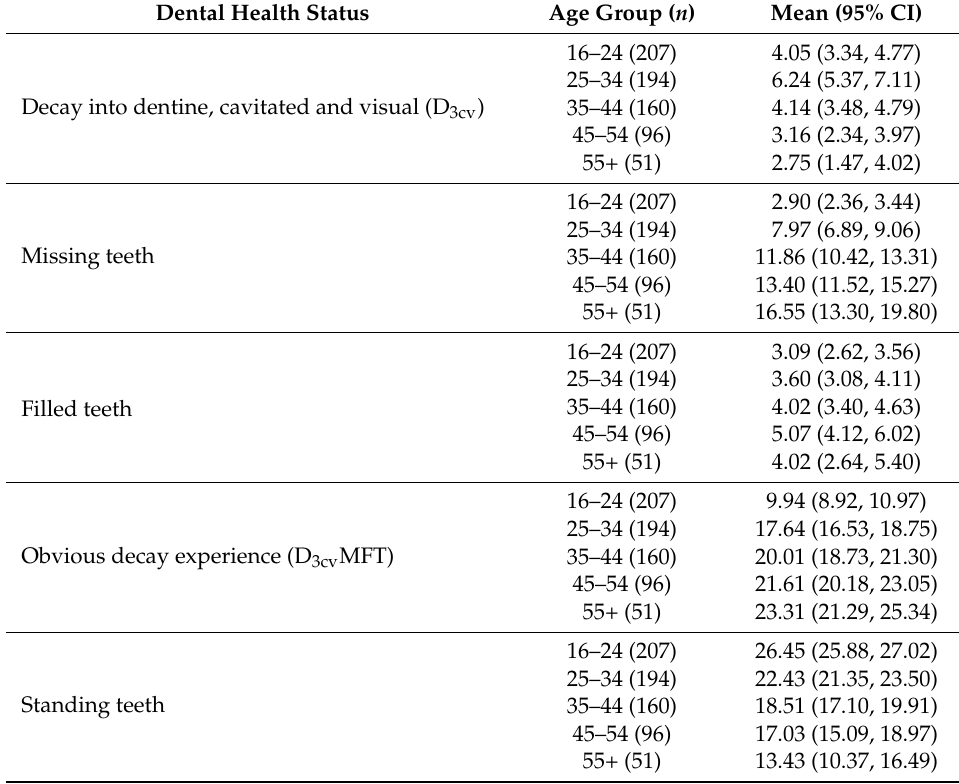
Table 2. Dental health status by age